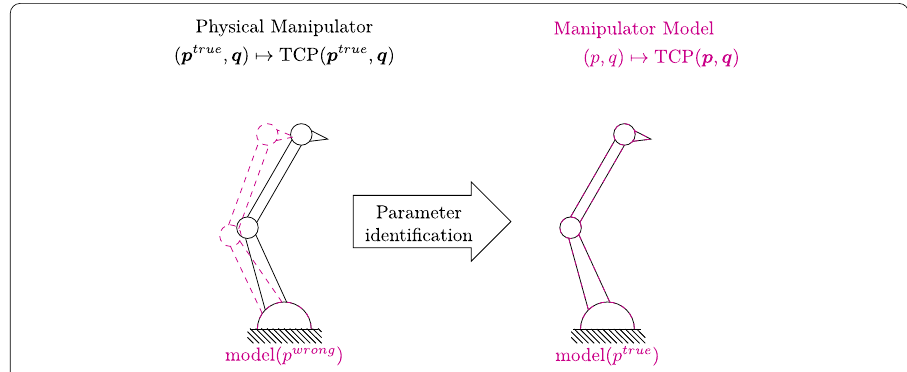
Figure 1 Concept of parameter identification of industrial manipulators. Unknown geometric parameters p lead to deviations between model prediction and actual tool center point (TCP) pose. On the left, the actual TCP pose TCP ( p true , q ) (in solid-black) and the predicted TCP pose TCP ( p , q ) (in red-dashed) are shown before the parameter identification and they do not coincide. The identification tries to eliminate these deviations by estimating the true parameters of the real manipulator. On the right, the actual TCP pose (in solid-black) and the predicted TCP pose (in red-dashed) coincide after the parameter identification procedure (for p = p true